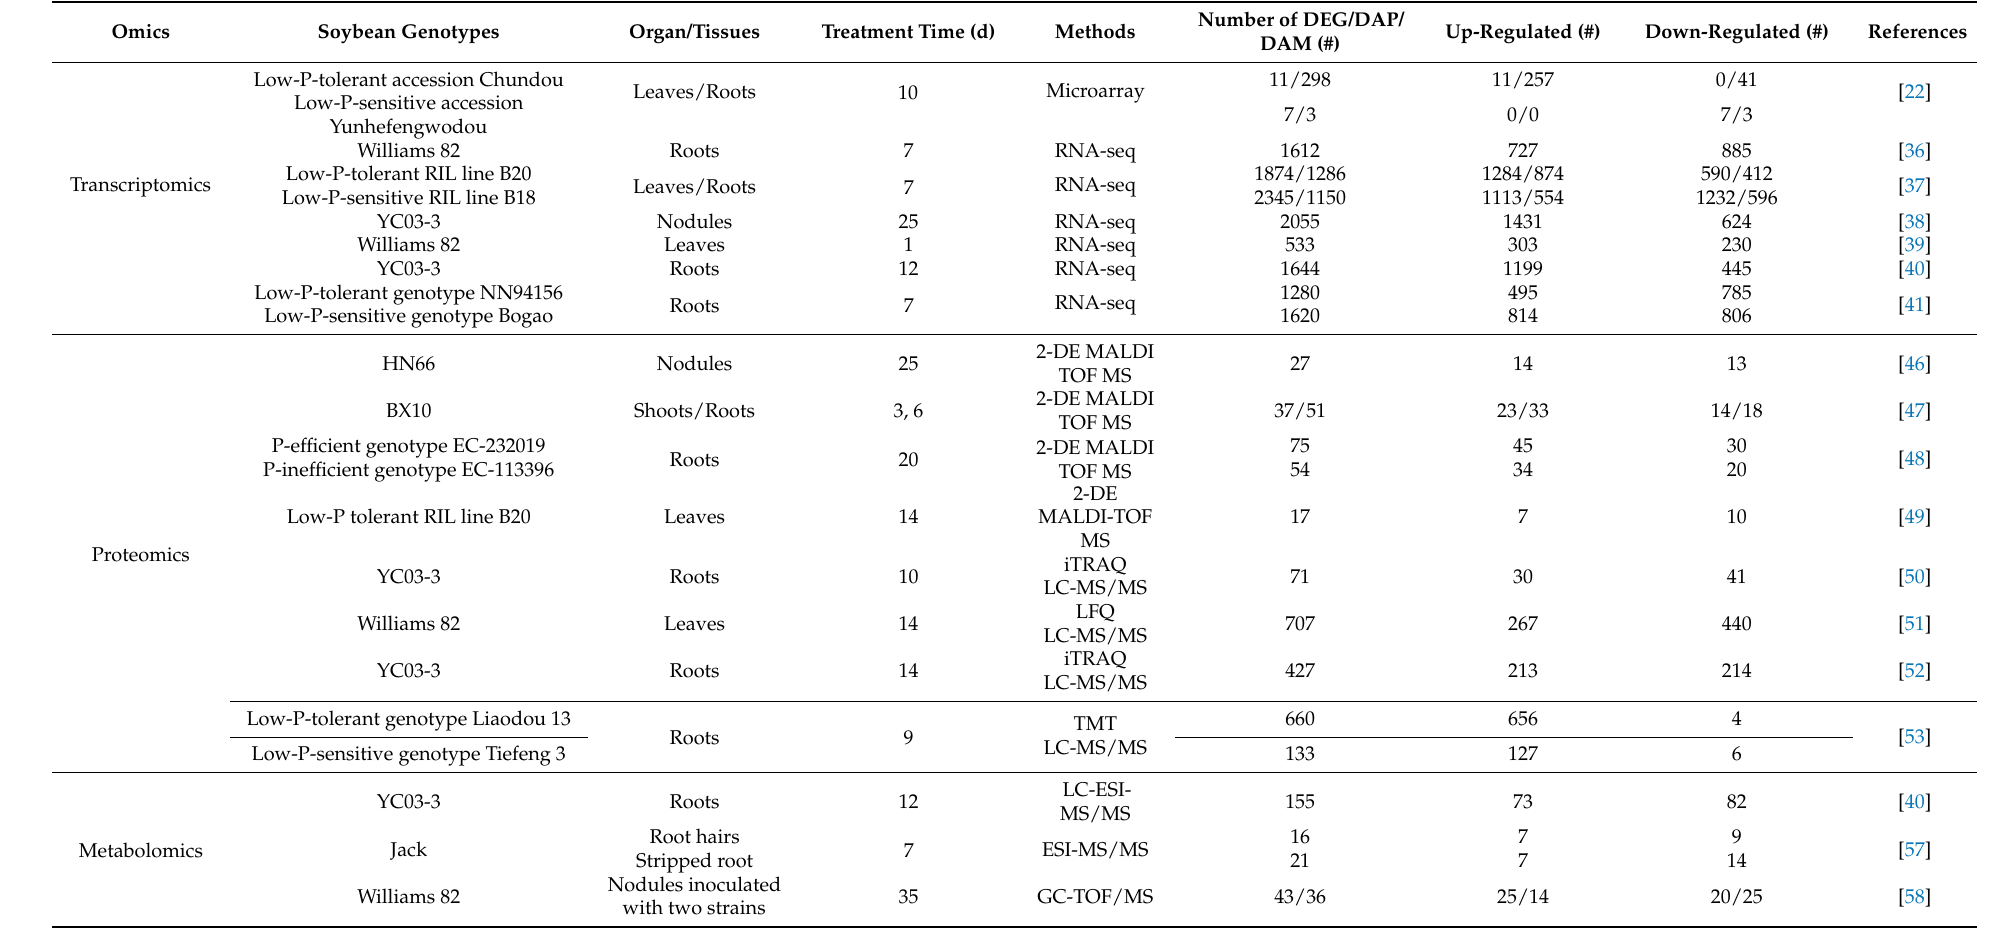
Table 1. A list of omics analyses of soybean responses to phosphate